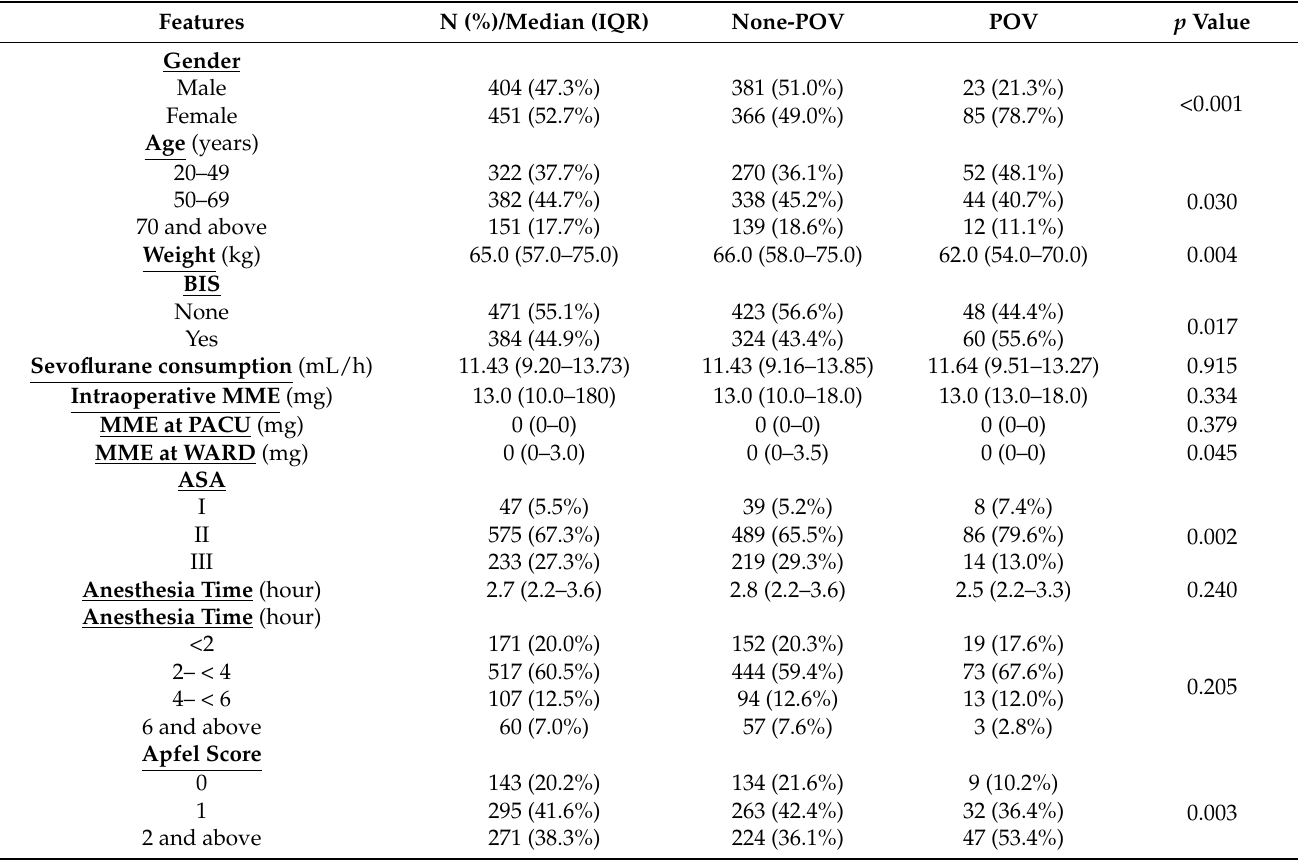
Table 1. Demographic and clinical characteristic features of surgical trauma